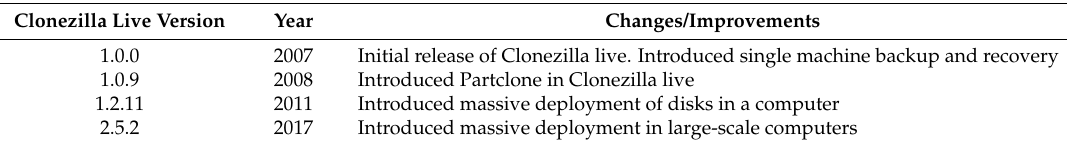
Table 2. Lists of the major changes to and improvements in Clonezilla live’s development.